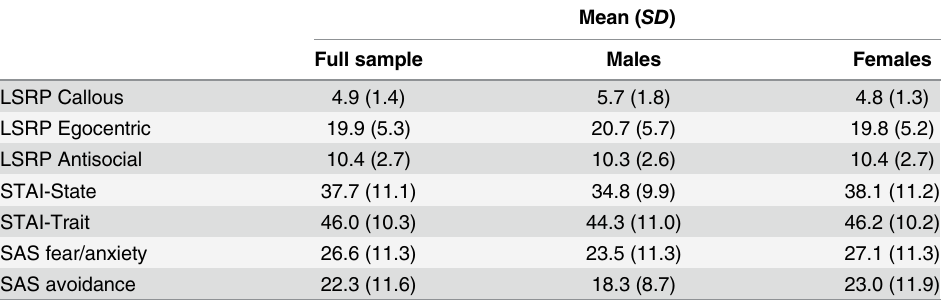
Table 1. Mean, standard deviation, and minimum and maximum scores for the callous, egocentric, and antisocial subscales of the LSRP, state anxiety, trait anxiety, and social fear/anxiety and avoid- ance